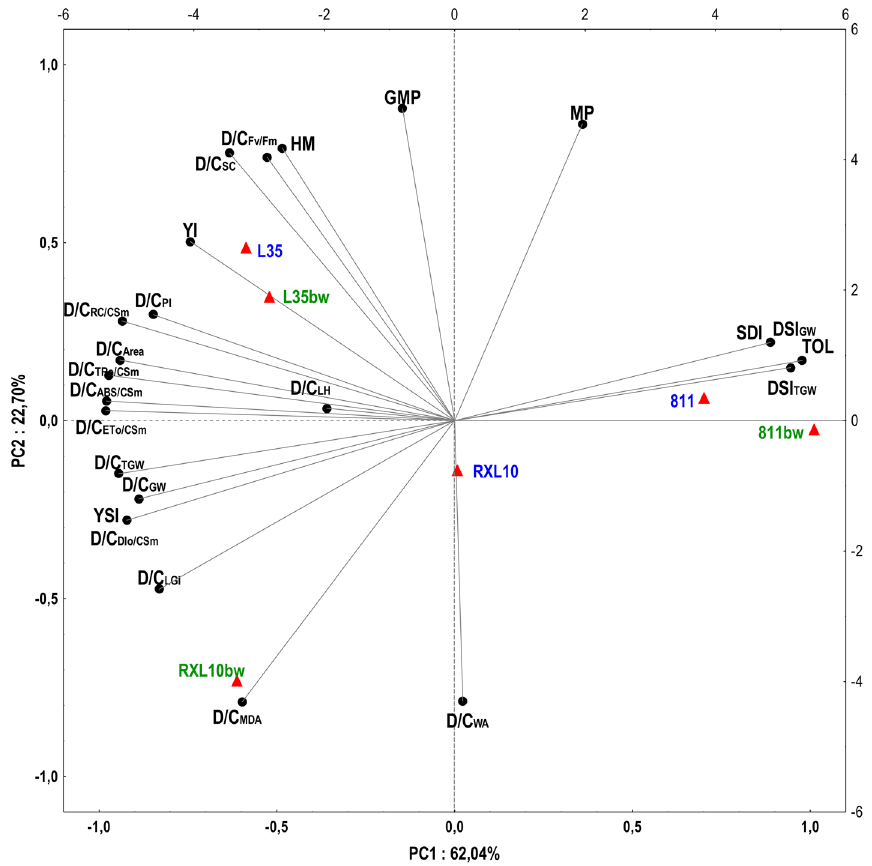
Figure 8. Principal component analysis (PCA) presented as a biplot (projection of cases and projection of variables) on the plane of the first two factor axes (PC1, PC2) performed for variables differentiating the studied near-isogenic glaucous (811, L35, RXL10; marked in blue) and non-glaucous (811bw, L35bw, RXL10bw; marked in green) rye lines in terms of physiological and biochemical responses to soil drought and yield. The following variables were analysed: the drought to control percentage ratio (D/C) of chlorophyll fluorescence kinetic parameters (F v /F m , Area, PI, ABS/CS m , TR o /CS m , ET o /CS m , DI o /CS m , RC/CS m ), stomatal conductance ( g s ), leaf greenness index (LGI), malondialdehyde (MDA) content, leaf hydration (LH), wax amount (WA) and yield-related drought resistance indices, i.e., the drought to control percentage ratio (D/C GW and D/C TGW ) and Drought Susceptibility Index (DSI GW and DSI TGW ) calculated based on grain weight (GW) and thousand grain weight (TGW), and indices calculated based on grain weight, i.e. tolerance index (TOL), mean productivity (MP), harmonic mean (HM), geometric mean productivity (GMP), Yield Index (YI), Sensitivity Drought Index (SDI), Yield Stability Index